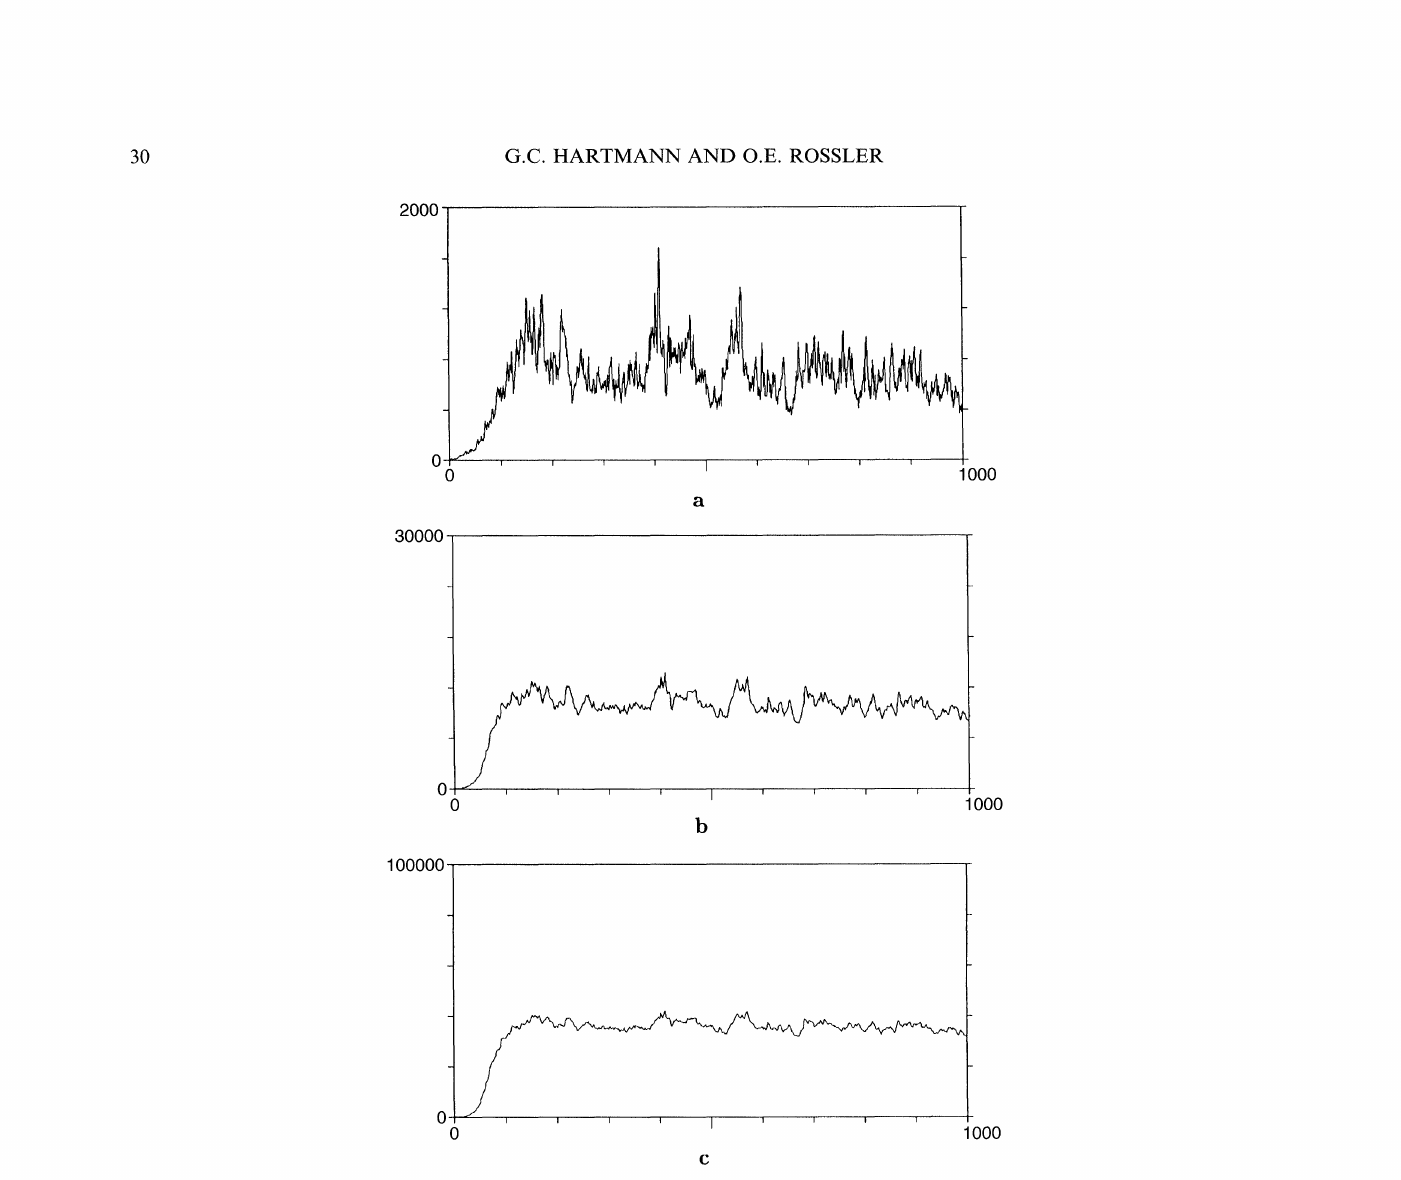
FIGURE 5 "Finite decay plot". Numerical simulation of Eq. (3), with the last line of Eq. (3) replaced by Eq. (4). (a) Almost no smoothing (a =0.99); this picture is almost indistinguishable from Fig. 4(d). (b) Medium smoothing (a=0.2). (c) Strong smooth- ing (a 0.05). Compare